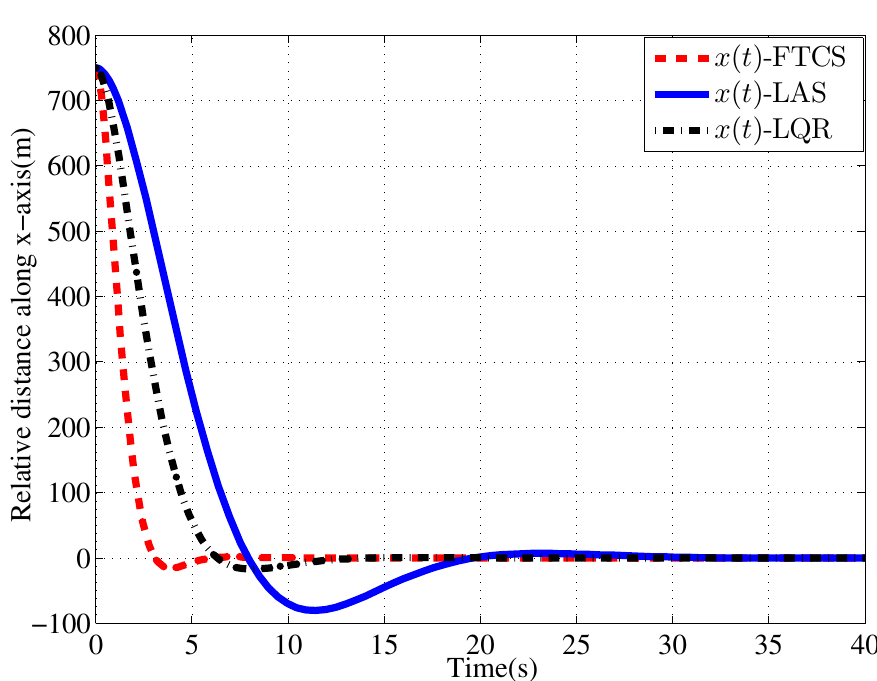
Figure 3. Relative position along x -axis under different control laws.